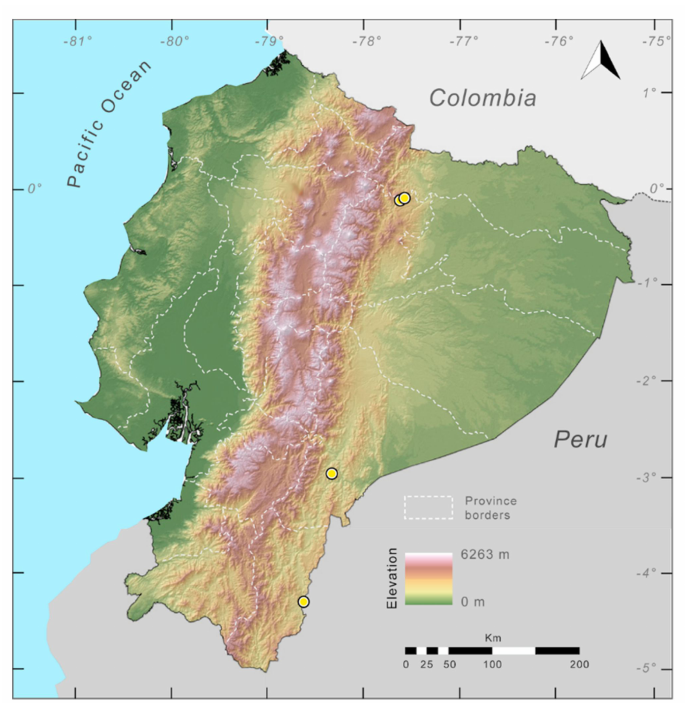
Figure 120. Distribution of Hyalinobatrachium pellucidum in Ecuador (yellow